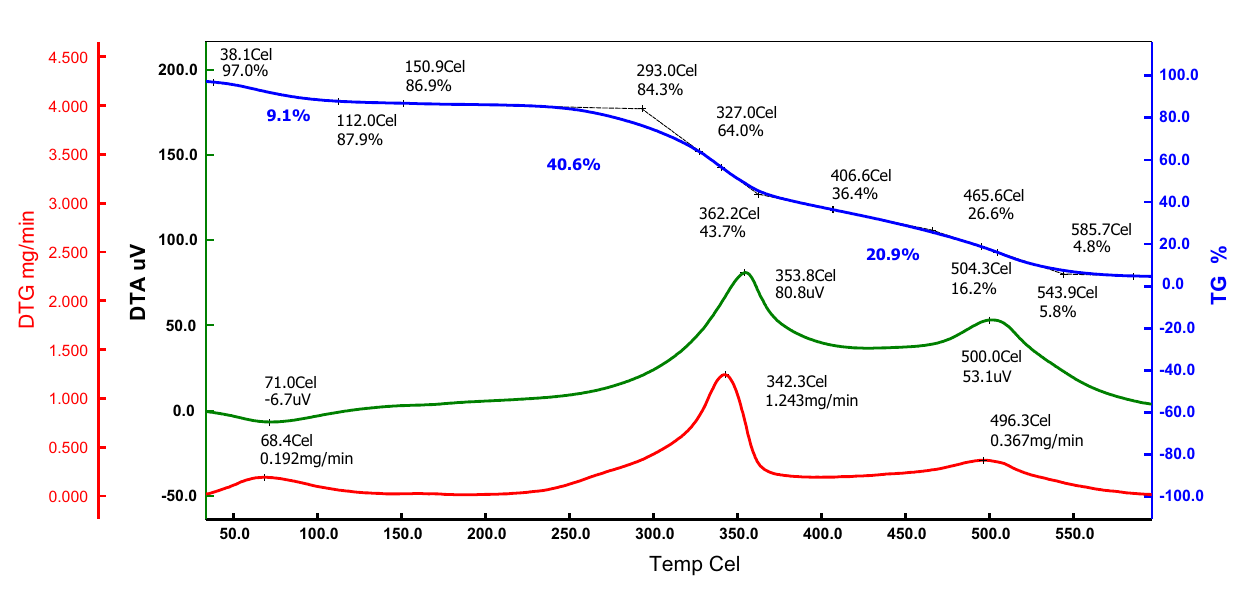
Fig. 2 FTIR spectra of spent tea leaves (STL)